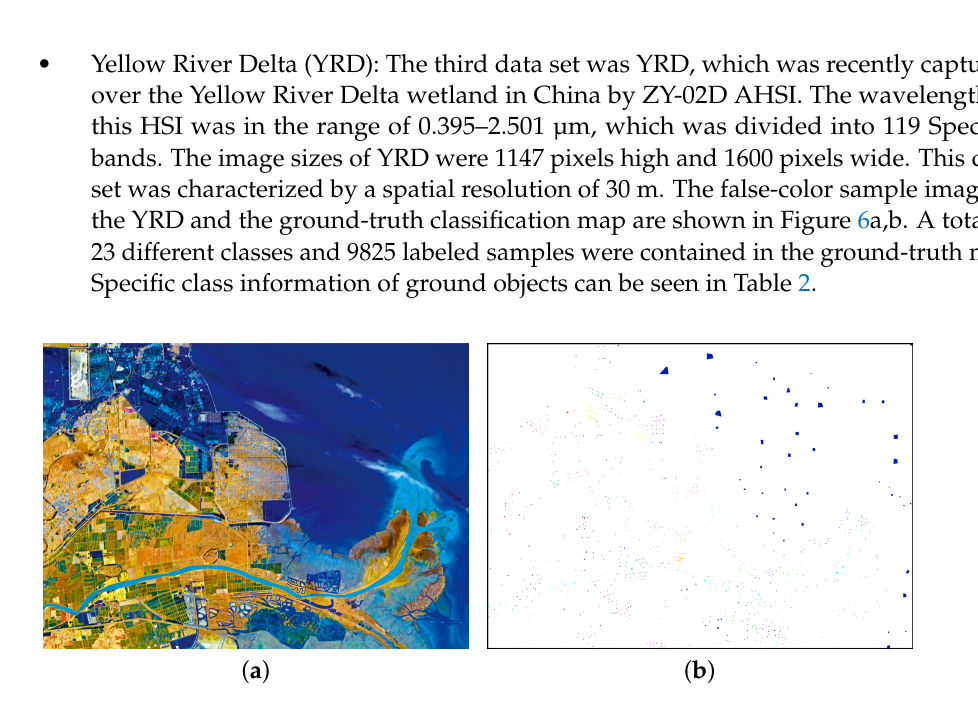
Figure 6. Yellow River Delta. ( a ) False-color image, ( b ) Ground-truth